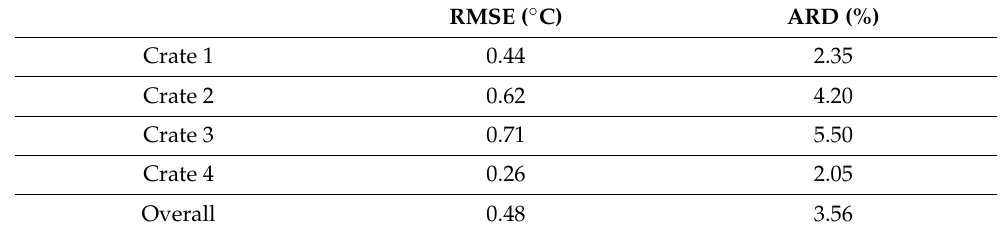
Table 3. Model prediction errors.